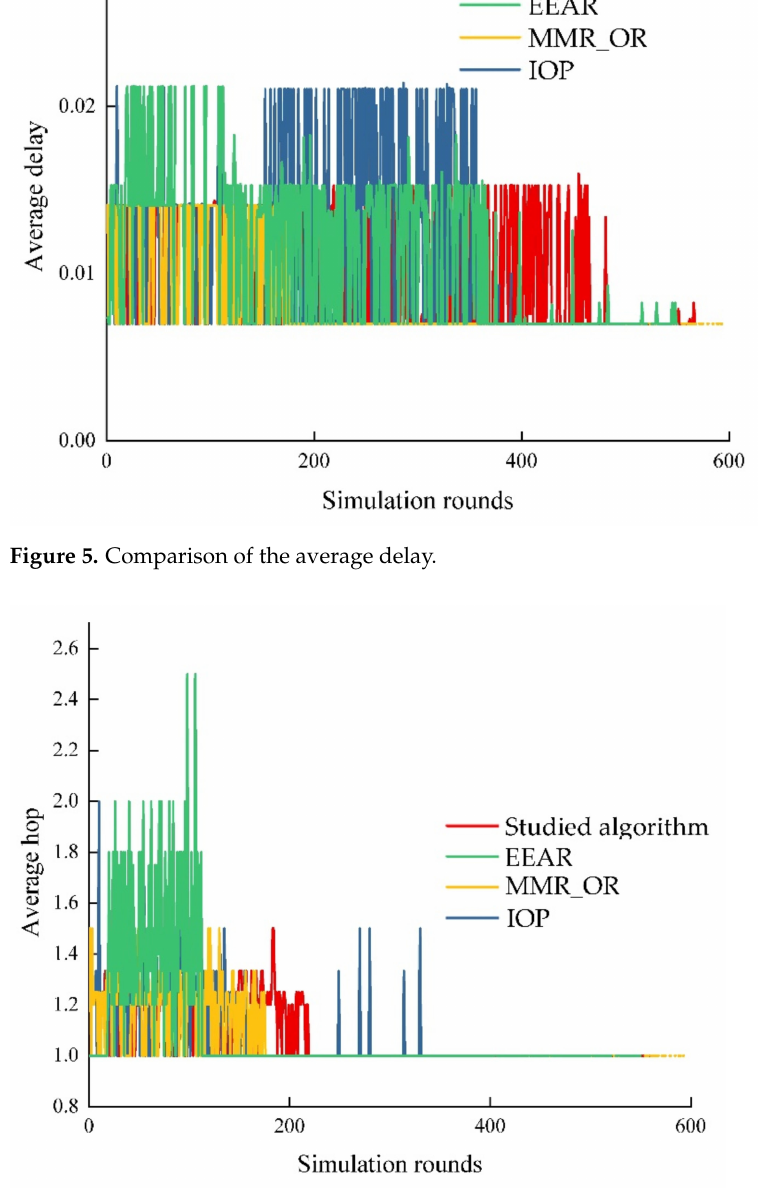
Figure 6. Comparison of the average